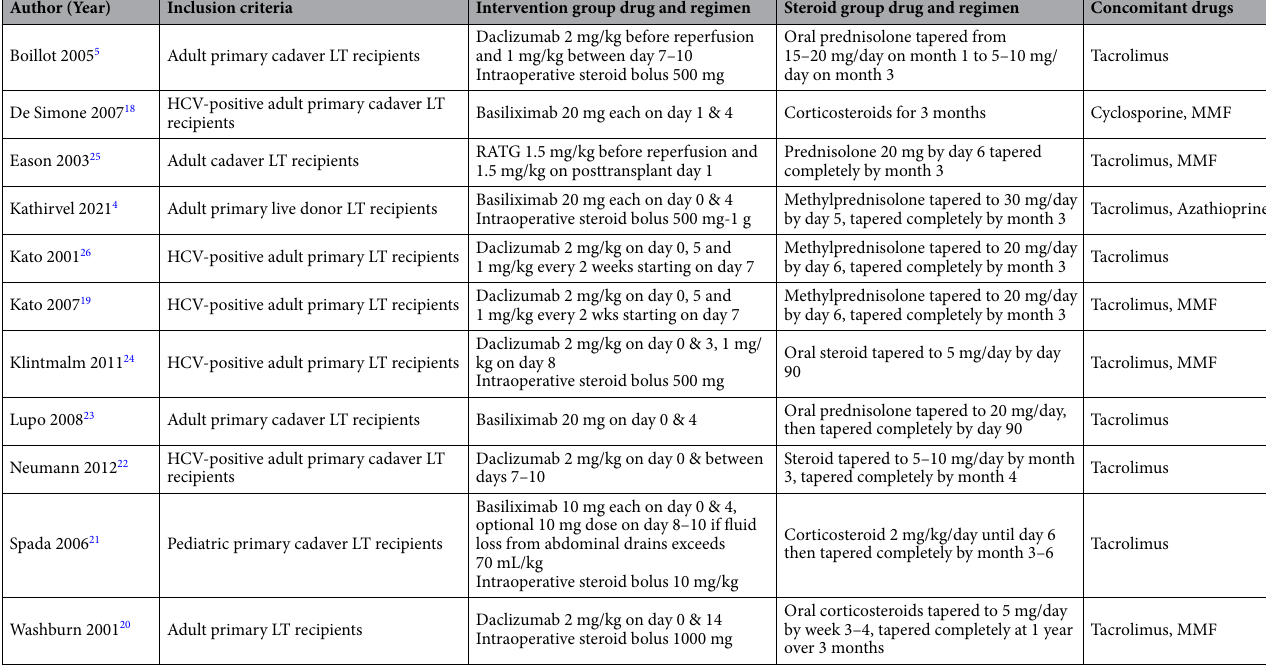
Table 1. Characteristic of the included trials. LT = liver transplant, HCV = hepatitis C virus, MMF = mycophenolate mofetil, ATG = antithymocyte